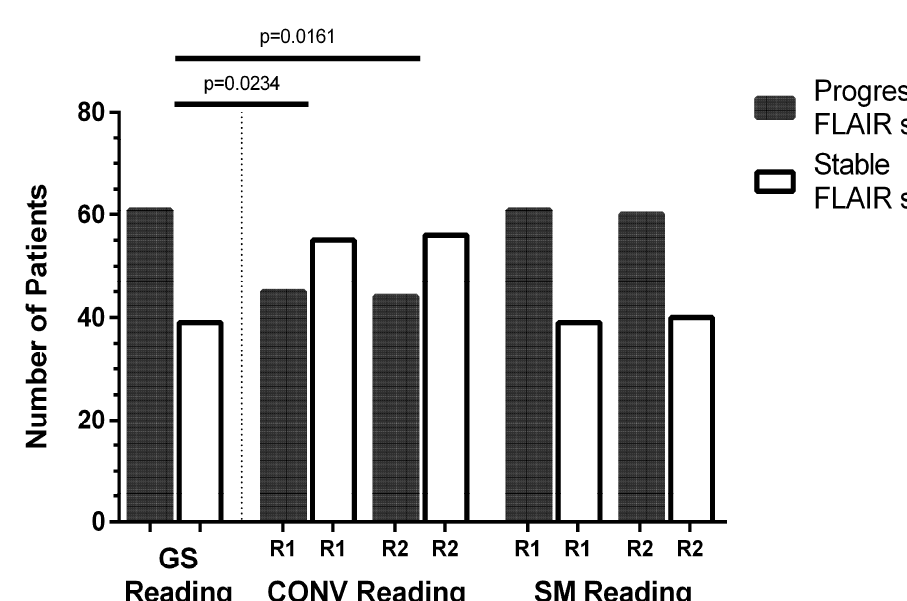
Figure 3. Evaluation of signal changes—stable versus progressive signal. Gold-standard (GS) reading defined 61 patients to show increases of the fluid attenuated inversion recovery (FLAIR) signal and the remaining 39 patients to show stable FLAIR signal alterations. Subtraction map (SM) reading was in good accordance with GS reading according to both readers (R1 and R2), with 61 patients (R1) / 60 patients (R2) being correctly identified to show progressive FLAIR signal (R1: p = 1.0000, R2: p = 0.8850). Increasing FLAIR signal for 16 patients (R1) / 17 patients (R2) was missed in conventional (CONV) reading (R1: p = 0.0234, R2: p = 0.0161).